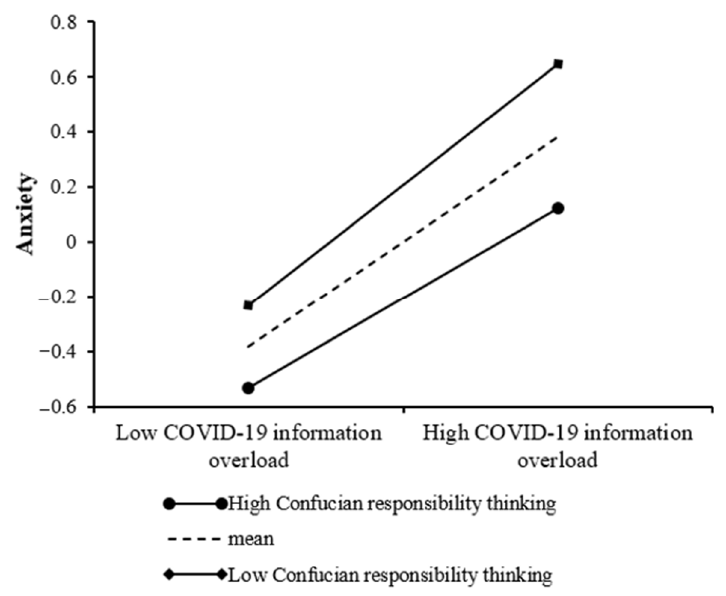
Figure 3. Confucian responsibility thinking moderates the relationship between COVID-19 informa- tion overload and anxiety.